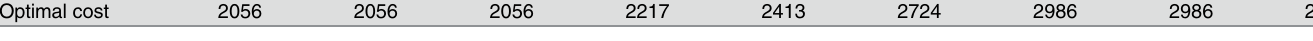
Table 1. The Relationship between the Threshold and the Optimal Cost. Threshold of q